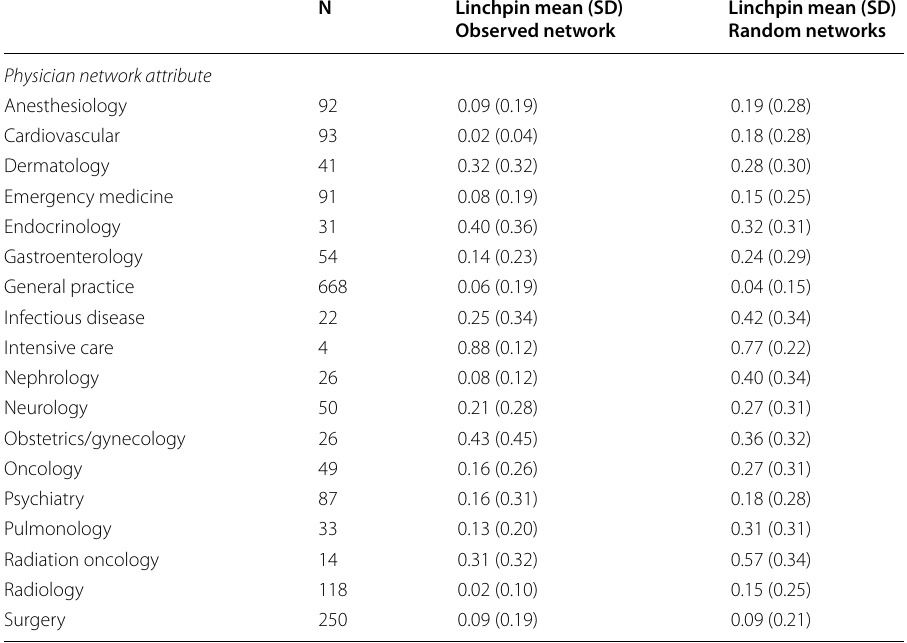
The number of nodes (N) represents the number of physicians with that specialty in the Providence, RI physician network. The linchpin mean and SD for the observed network are presented alongside the linchpin mean and SD for 10 permuted networks where the network structure was constant but specialty was randomly assigned. SD, standard